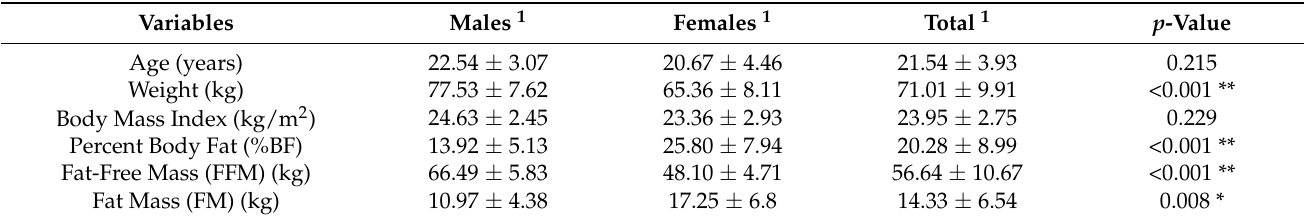
Table 1. Demographic